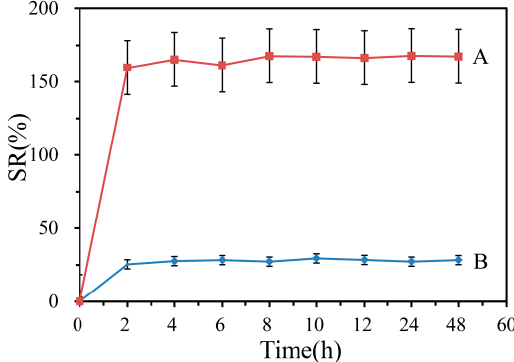
Figure 8. Swelling ratio of electrospinning nanofibers. A: nanofibers with emodin; B: nanofibers without emodin.